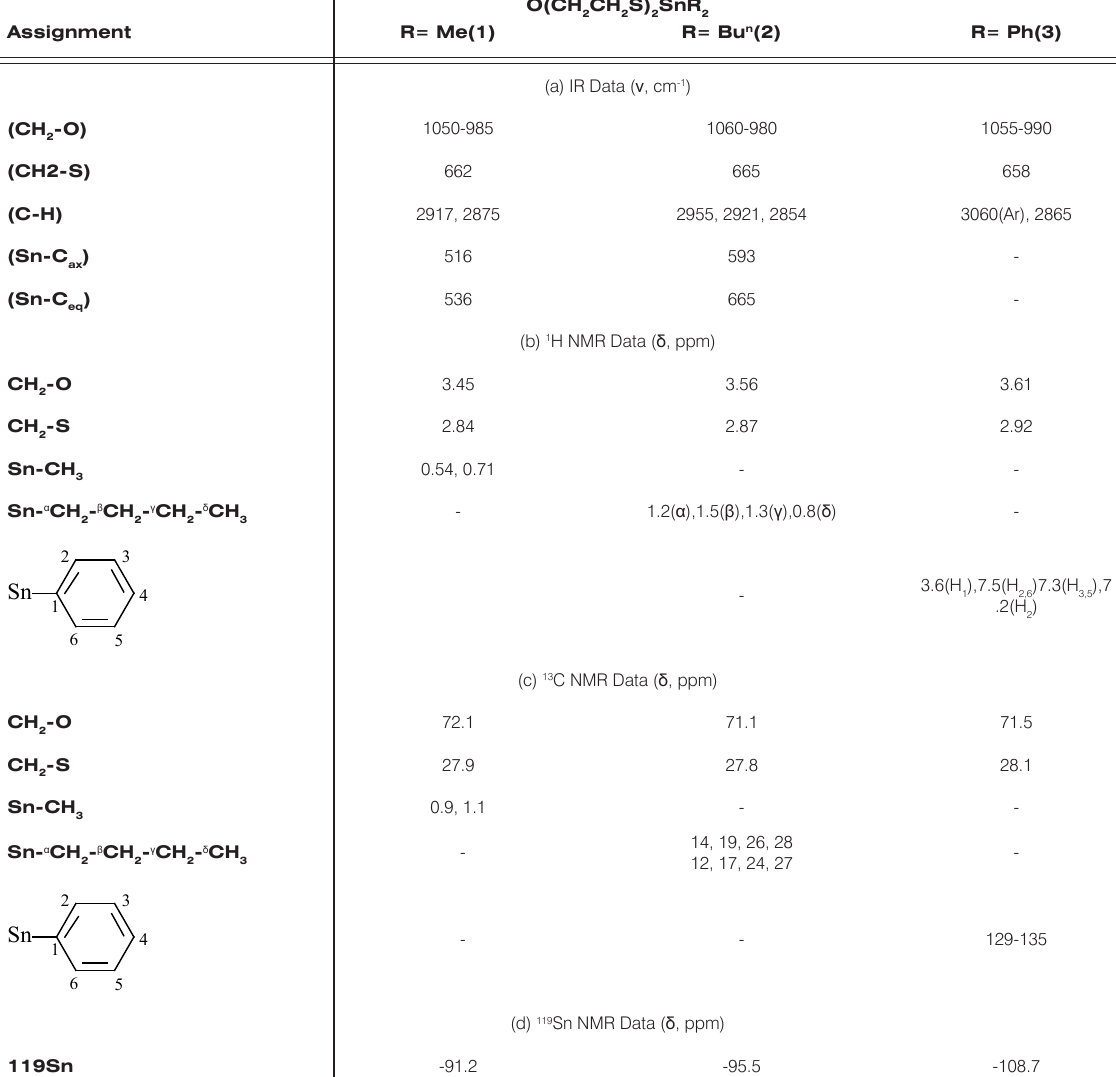
Table 1. Selected spectroscopic results for the stannocanes (1) to (3)